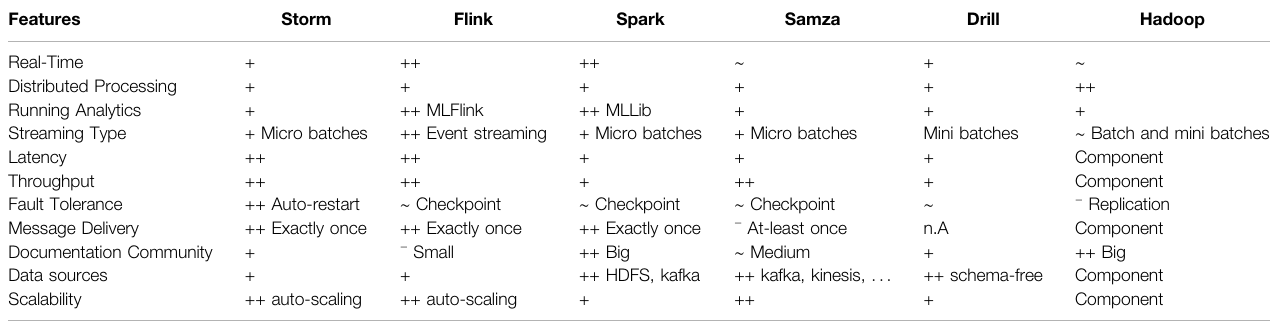
TABLE 1 | Comparison of analytical tools for Big Data. The categories are chosen upon in fl uence within a Big Data system and range from “ ++ ” (very good ful fi llment) to “–” (not ful fi lled). Additional information is given according to the requirements.